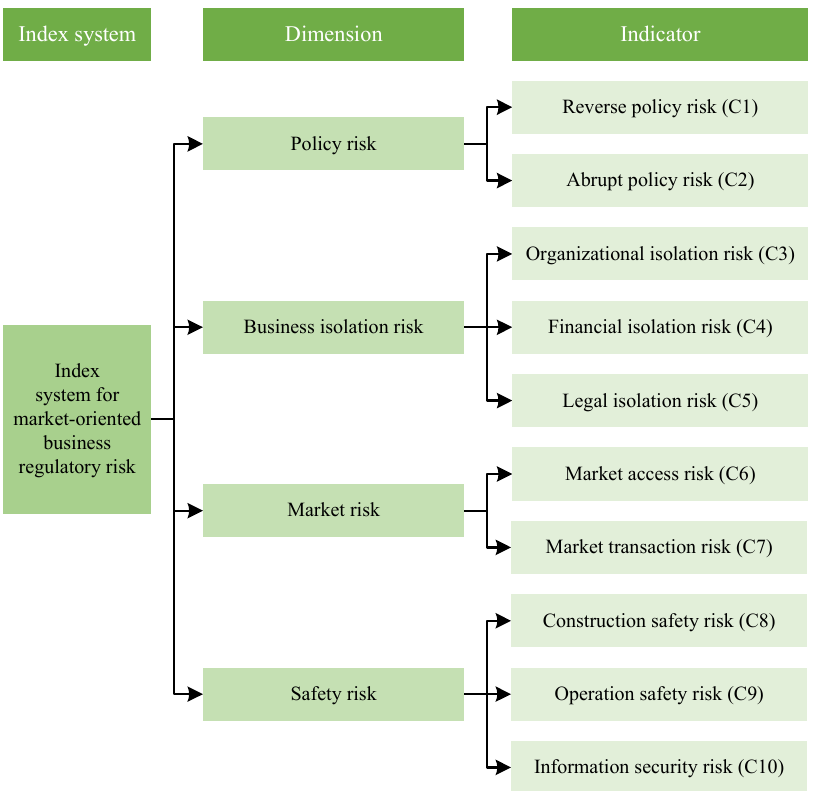
Figure 1. Regulatory risk evaluation index system of market ‐ oriented business for power grid en ‐